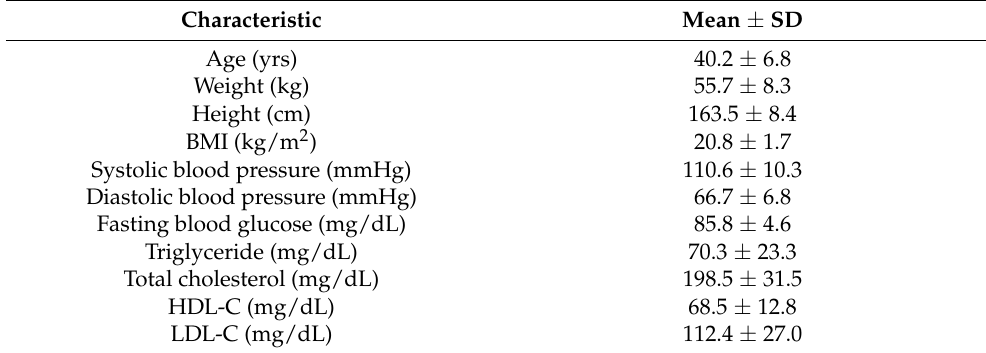
Figure 2. Changes in postprandial blood glucose, insulin secretion, and AUC. Blood glucose ( A ) and insulin ( B ) readings at each elapsed time of the first and second meals. AUC of blood glucose ( C ) and AUC of insulin ( D ) at first meal. AUC of blood glucose ( E ) and AUC of insulin ( F ) at second meal * p value < 0.05. ** p value < 0.01. *** p value < 0.001. Table 4. Descriptive characteristics of the study